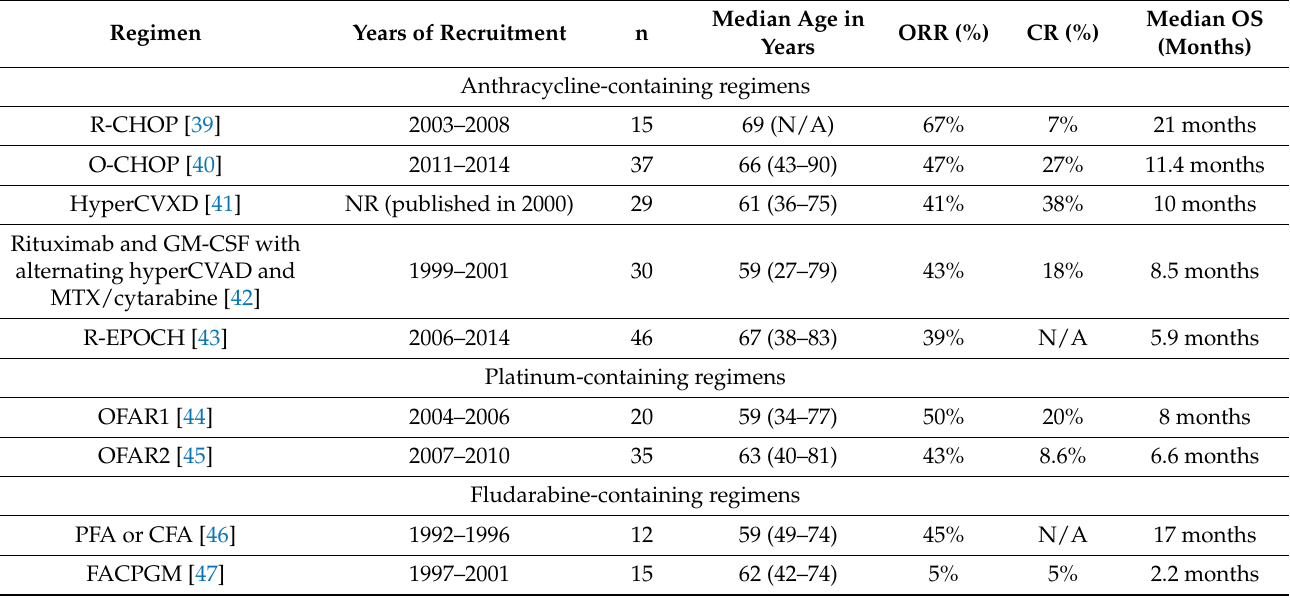
Table 2. Combination chemotherapy